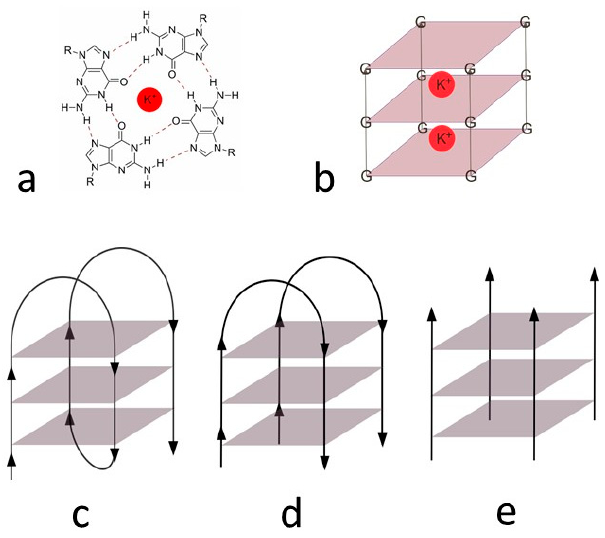
Figure 2. G-tetrad ( a ) and three-dimensional schematic structure with potassium ions ( b ), unimolec- ular ( c ), bimolecular, ( d ) tetramolecular, and ( e ) G-quadruplex.